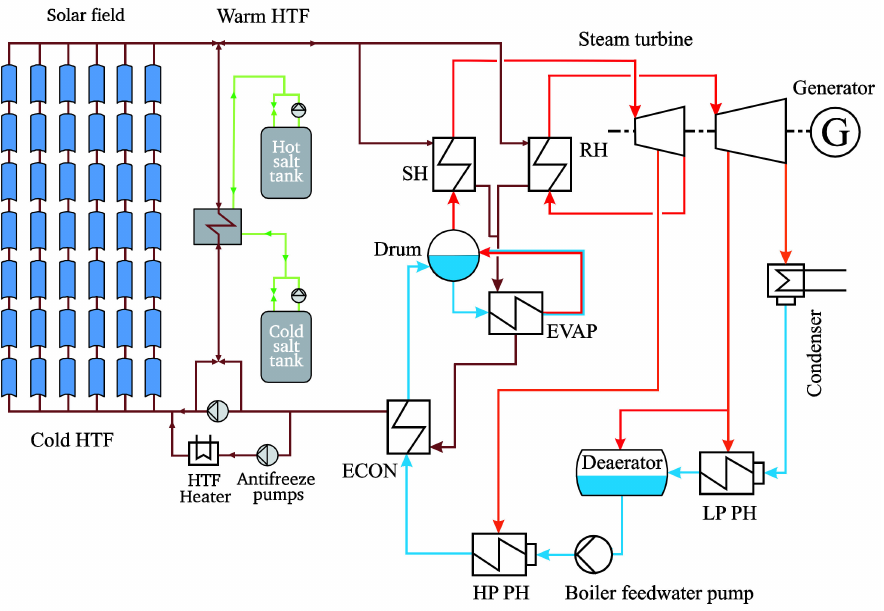
Figure 1. Parabolic trough power plant with a thermal storage